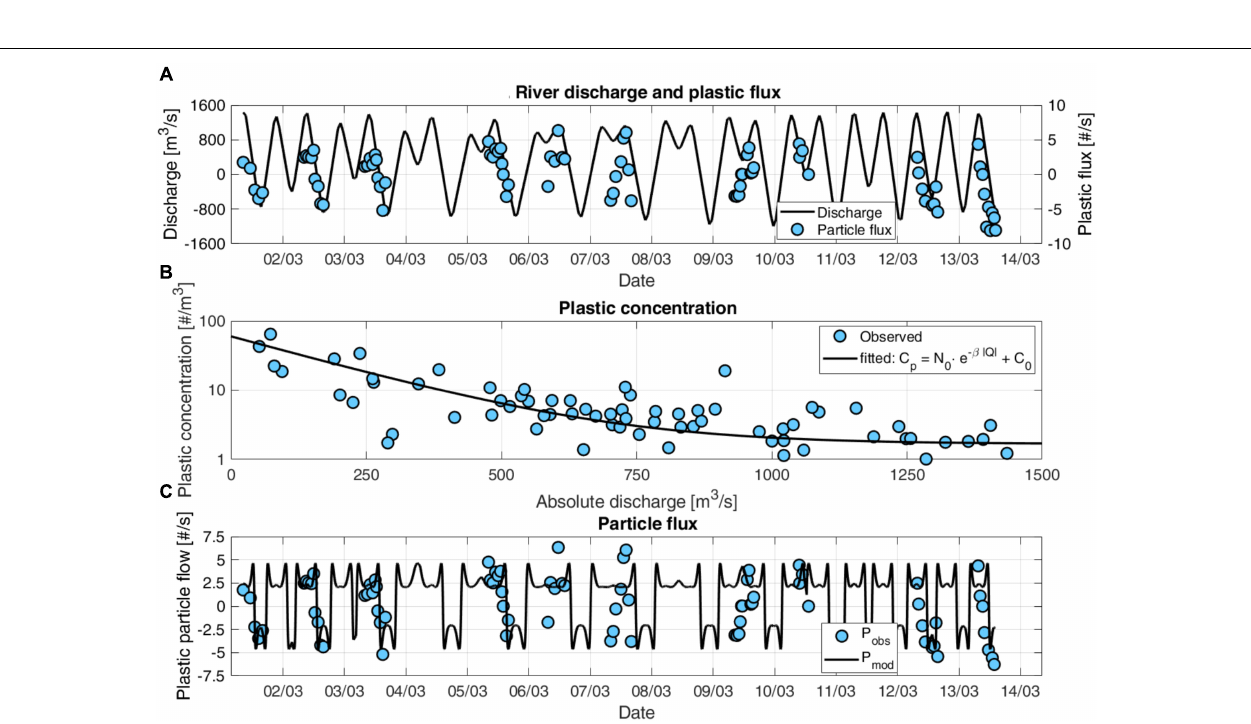
FIGURE 6 | (A) Total number of plastic pieces per second, and modeled discharge in the Saigon River, (B) modeled plastic concentration as a function of discharge ( N 0 = 58, β = 5 · 10 − 3 , and C 0 = 1.7) and (C) modeled and measured plastic